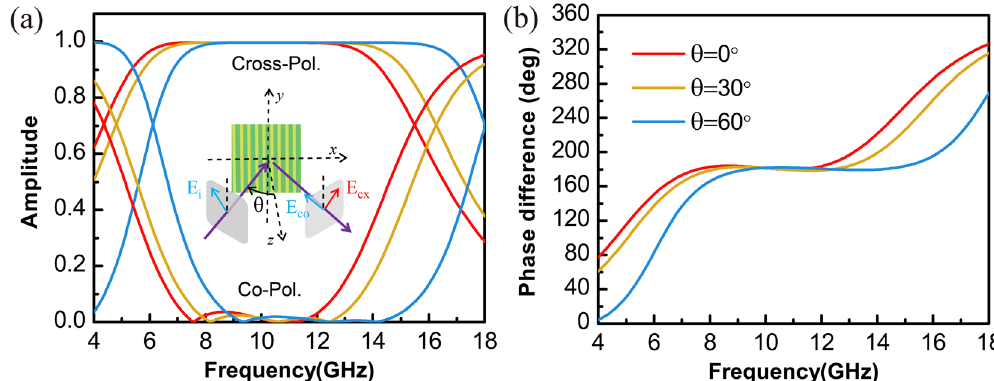
Figure 4. Numerical results for the proposed half-wave plate under oblique incidence. ( a ) Amplitude coefficients for the co-polarized and cross-polarized components of the reflected beam. ( b ) Phase difference of the reflected beams between cases where the polarizations of the input beam are parallel and perpendicular to the grating wires. The insect in ( a ) shows the oblique incidence situation under